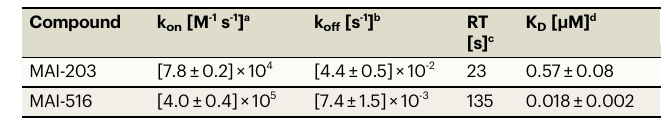
Table 4 | Peptide inhibitor MAI-517 – MAI-522 structures and APC binding af fi nities as measured by FP-based assays